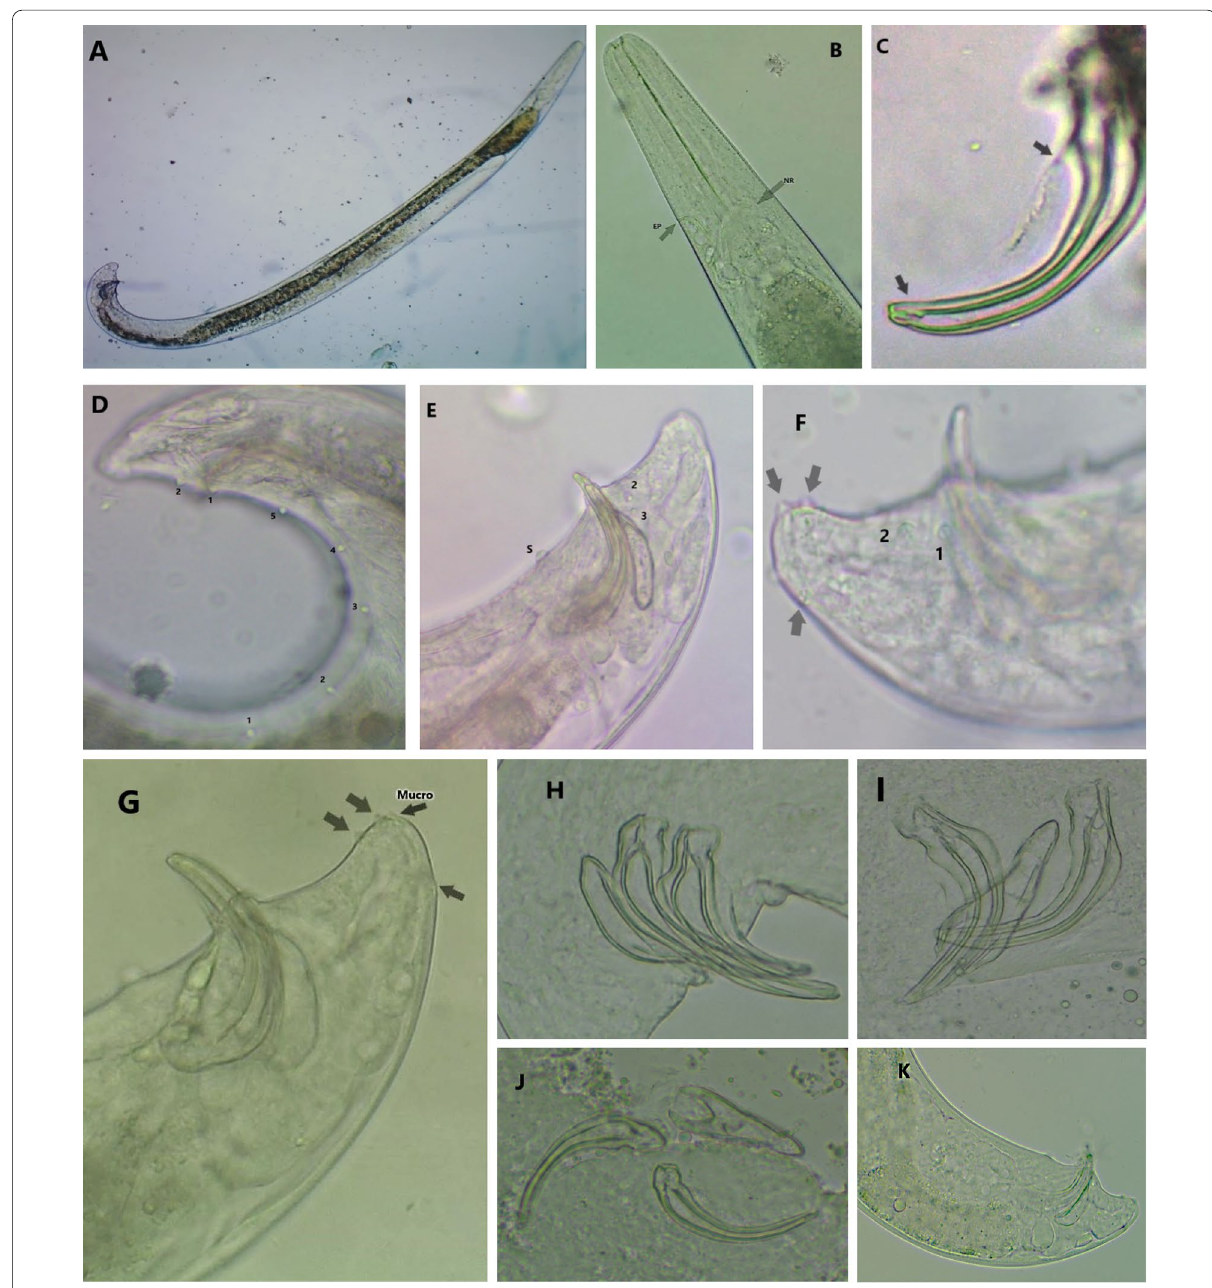
Fig. 2 Steinernema affine male . A : first generation entire body. B : the anterior portion, right arrow refers to nerve ring position while left arrow refers to excretory pore. C : arrows refer to velum of spicule. D : lateral view of the five pairs of papillae anterior to cloaca opening, addition to the two pairs of papillae (1st, 2nd) posterior to the gubernaculum. E : lateral view of adanal ventral one papillae (S), and two pairs of papillae posterior to the gubernaculum (2nd, 3rd). F : two pairs of papillae (1st, 2nd) posterior to the gubernaculum, the arrows refer to three pairs of papillae near the tail tip, G : arrows refer to mucro of tail which surrounded by three pairs of papillae. H : lateral view of spicules and gubernaculum. I : ventral view of gubernaculum. J: moderately curved spicules. K: second generation tail male without a mucro. A : 1481 µm. B: EP SL 65 µm. GL 50 µm. J SL 68 µm, GL 51 µm. K 41 = = = = = =